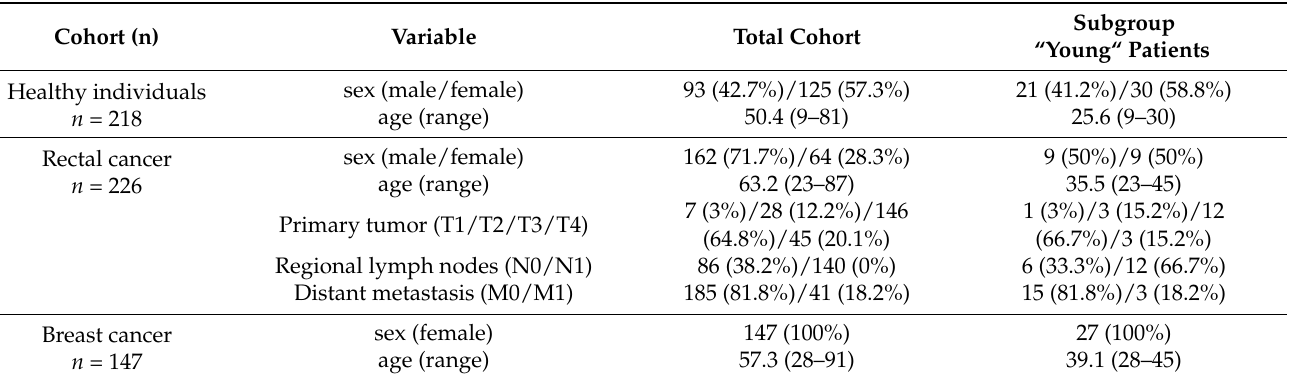
Figure 1. Case of a 6-year-and-8-month-old boy and radiation sensitivity testing. ( A ) Timeline since tumor diagnosis. ( B ) Proton therapy dose plan for the atypical teratoid/rhabdoid tumor ( B ) in a transverse plane and ( C ) a sagittal plane. ( D ) Timeline of radiation sensitivity assay. ( E ) A metaphase with the three stained chromosome pairs without aberrations. Red-stained chromosome #1, green-stained chromosome #2 and yellow-stained chromosome #4. ( F ) A metaphase with an insertion of a fragment of chromosome #2 into chromosome #1 and a dicentric chromosome consisting of chromosome #2 and an unstained chromosome. The yellow arrows point to the chromosomal aberrations. ( G ) The same image with DAPI staining shows that both damaged chromosomes are dicentric. The yellow arrows point to the centromeres.